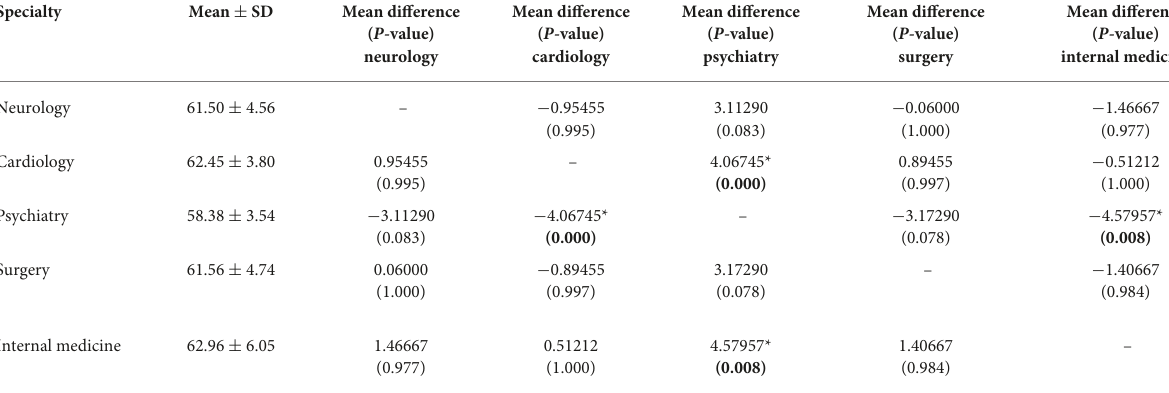
TABLE 2 Data descriptive: The mean total stigma score for mental illness among different medical residents and their comparison with one another. Specialty